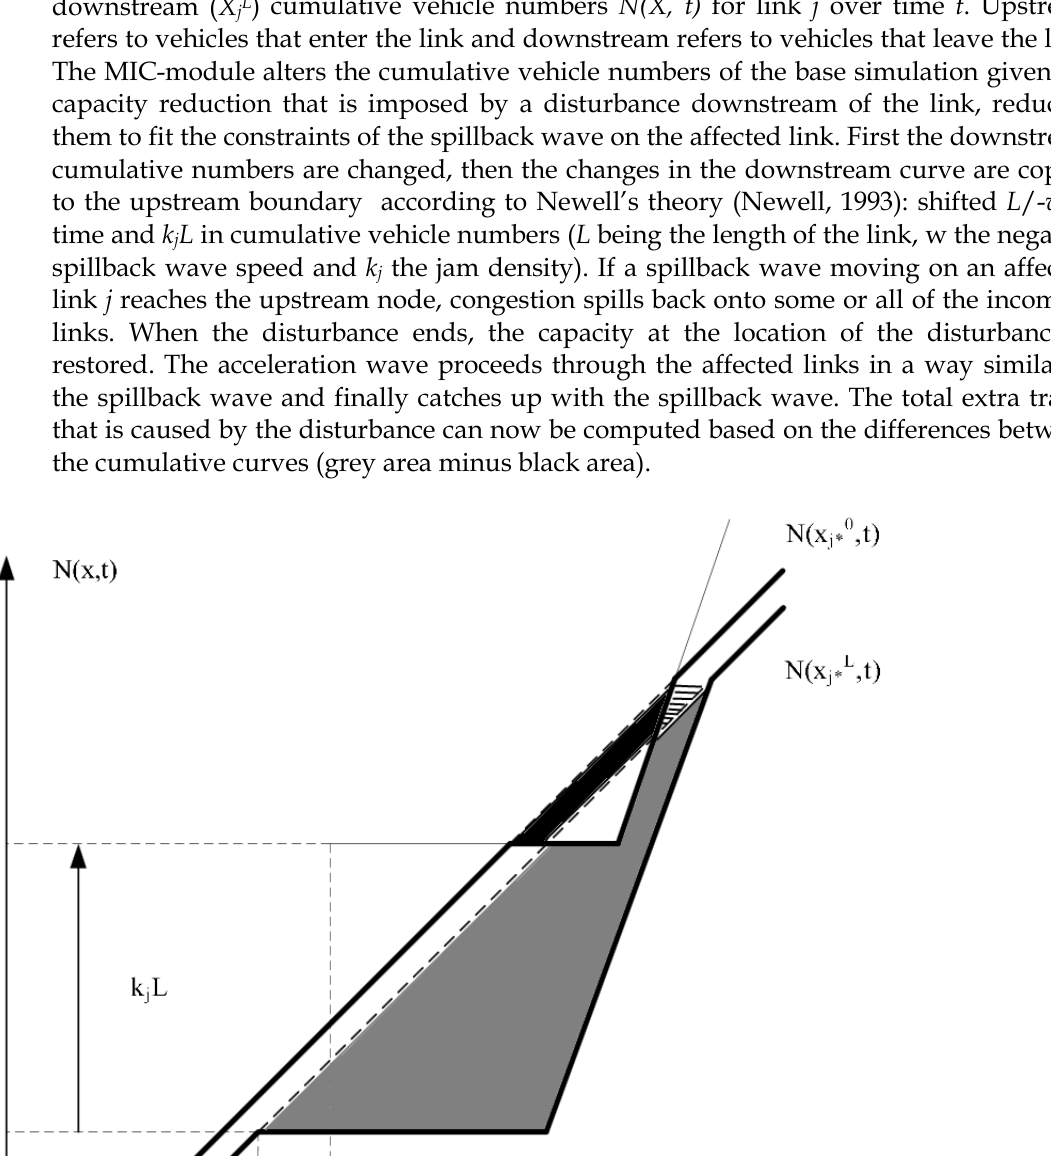
The MIC module assumes that vehicles do not change their behaviour during disturbances. This is a simplification because in practice some people will change their route, departure time, mode or even destination in case of severe disturbances. Therefore, the modelled situation represents a worst case